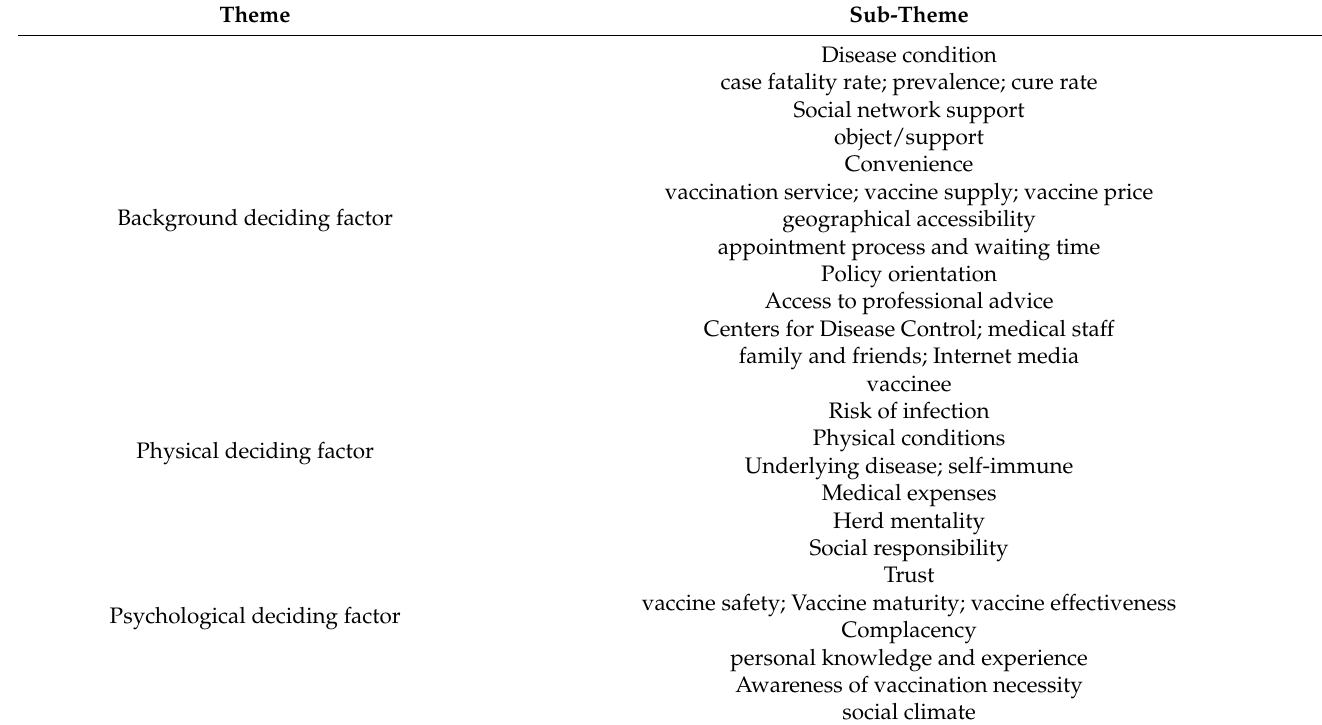
Table 1. Overview of factors influencing vaccine hesitancy in China mentioned by